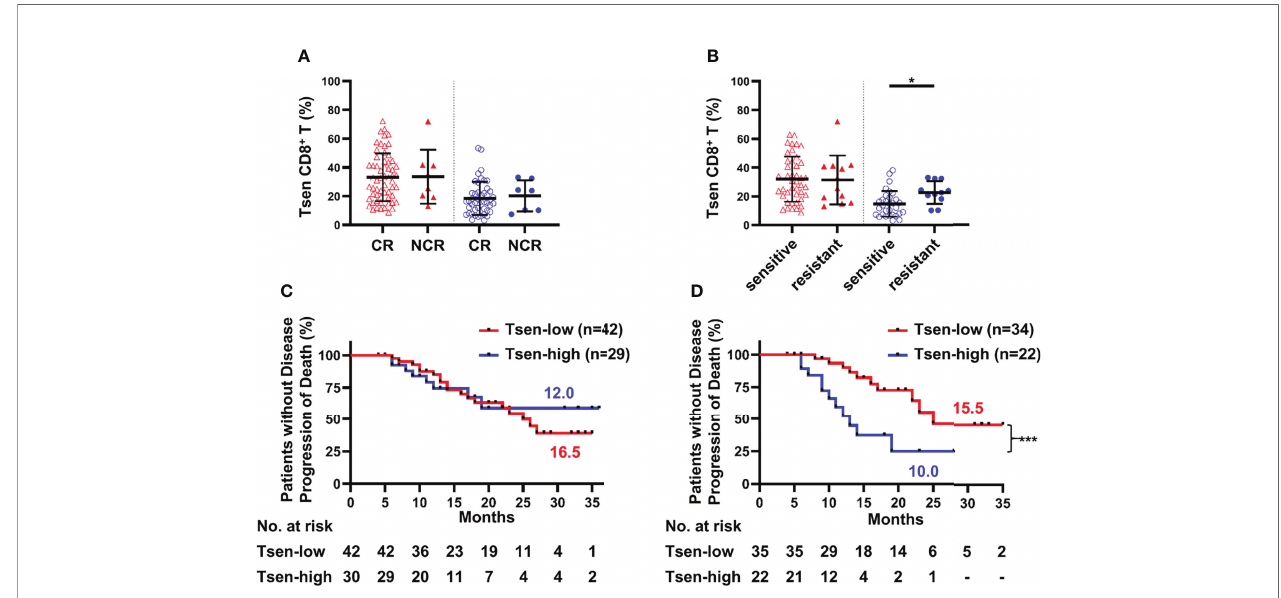
FIGURE 3 | Tsen CD8 + T cells are a negative predictor of prognosis. Patients were grouped according to (A) CR/NCR (peripheral blood: CR, n = 60, vs. NCR, n = 8; ascites: CR, n = 46, vs. NCR, n = 7) and (B) chemotherapy sensitivity (peripheral blood: sensitive, n = 43, vs. resistant, n = 12; ascites: sensitive, n = 31, vs. resistant, n = 11). Groups were compared using t-test. Bars show mean with SD. The correlation of PFS and Tsen CD8 + T cells in (C) peripheral blood and (D) ascites at diagnosis were analyzed by Kaplan – Meier estimates (Gehan – Breslow – Wilcoxon test). Groups were made on the basis of mean values of the complete cohort. *, P < 0.05; ***, P < 0.001.